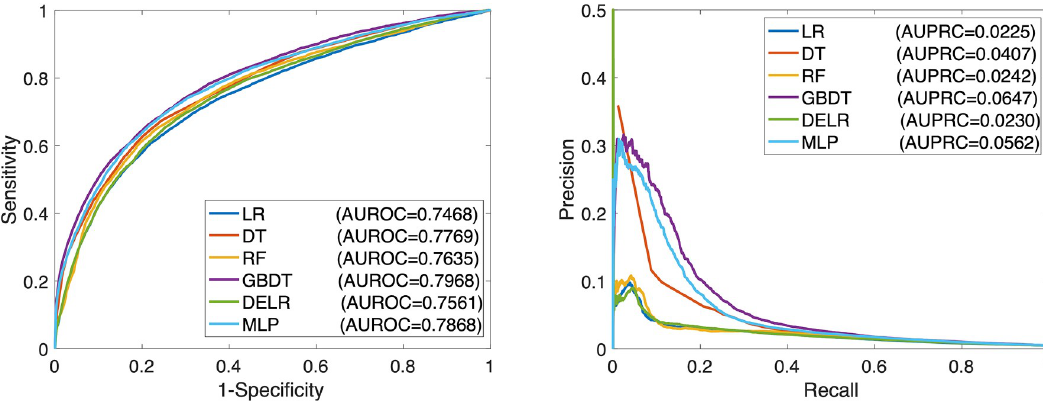
Fig 1. Model performance. Receiver operating characteristic curves (left panel) and precision-recall curves (right panel) demonstrating performance of each model in the testing set.